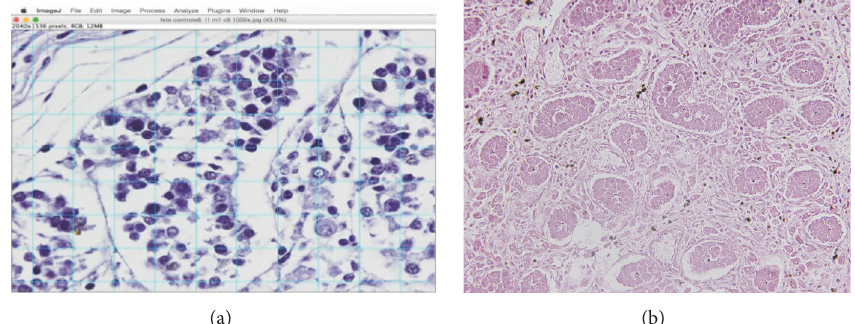
Figure 1: (a) Morphometric analysis of the seminiferous tubules and Leydig cells in fetal testis. The diameter of seminiferous tubules was measured using the program at least five times for each specimen and was determined by the contour of the epithelium. HE × 400. (b) Morphometric analysis of the seminiferous tubules and Leydig cells in fetal testis. To quantify the number of seminiferous tubules we used the Image J Test grid software to determine the volumetric density ( Vv ). HE ×